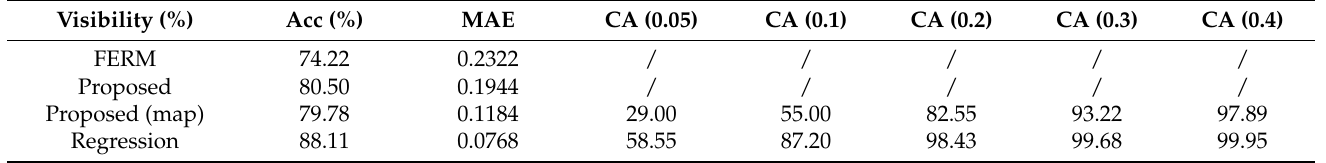
Table 8. The experimental results of different methods with the INDF dataset.